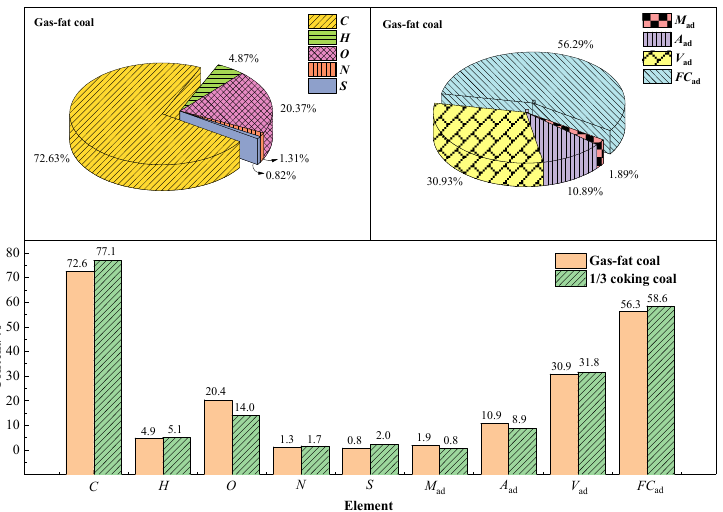
Figure 1. Proximate and elemental experimental